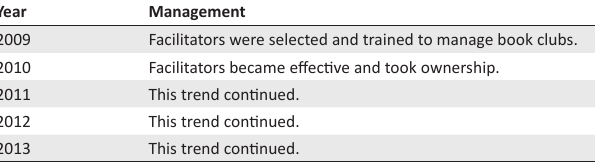
TABLE 2: Themes identified from monthly and yearly reports and field notes: Management of the book clubs and